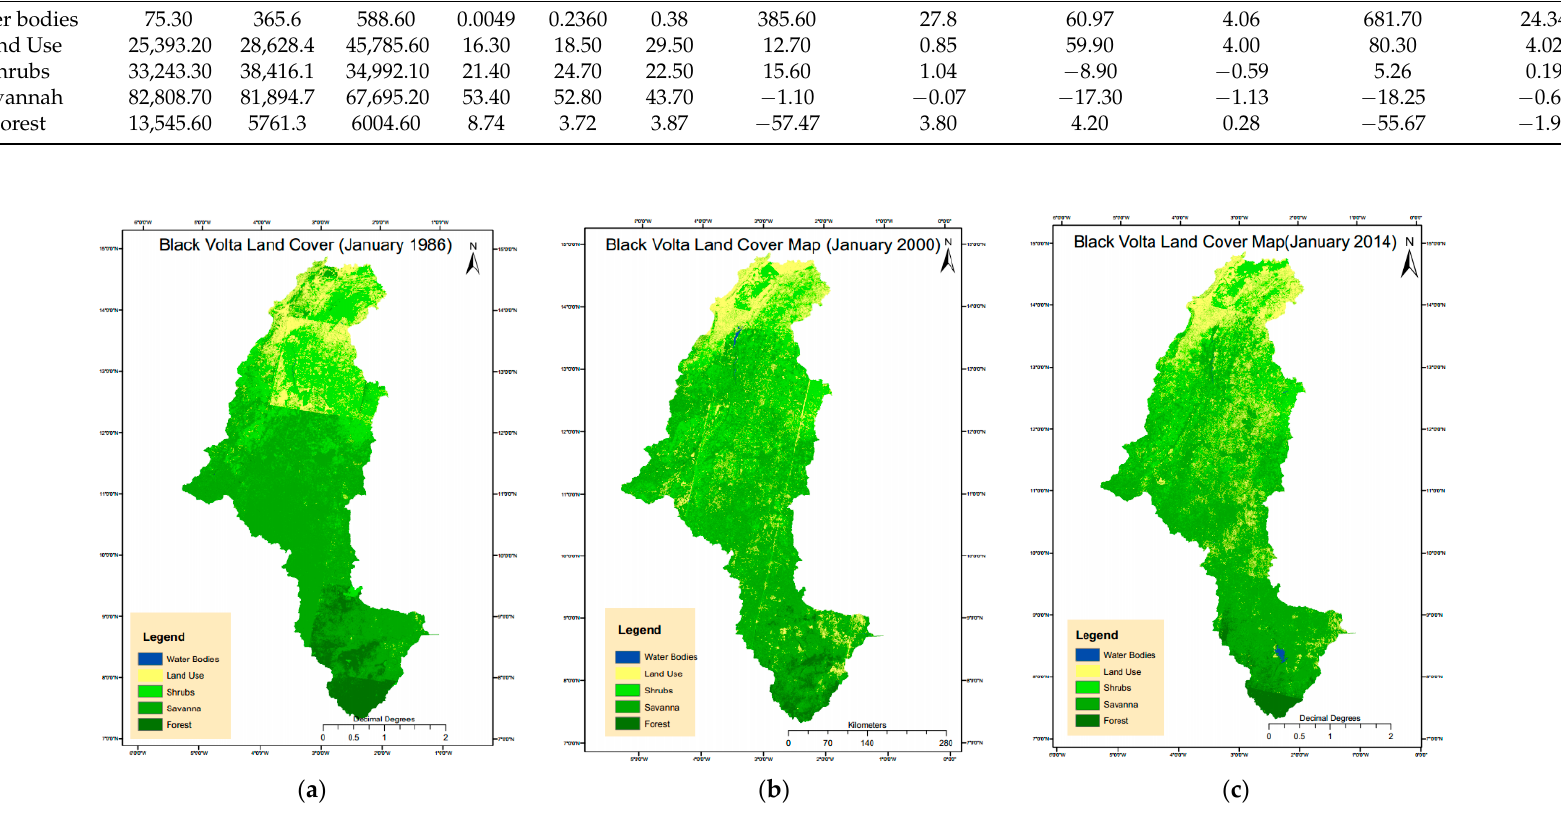
Figure 3. LULC maps. ( a ) LULC 1986; ( b ) LULC 2000; and ( c ) LULC 2014.